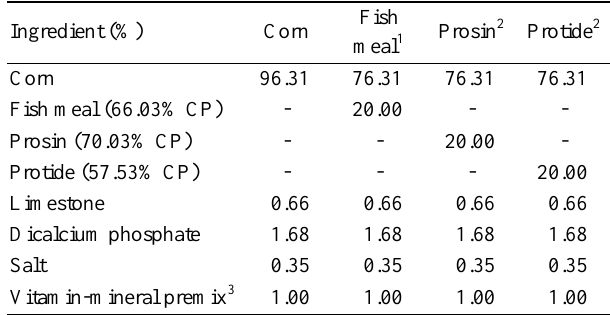
Table 2. Ingredient composition of experimental diets containing fish meal and single-cell proteins (Prosin and Protide) (as-fed basis), Exp. 1